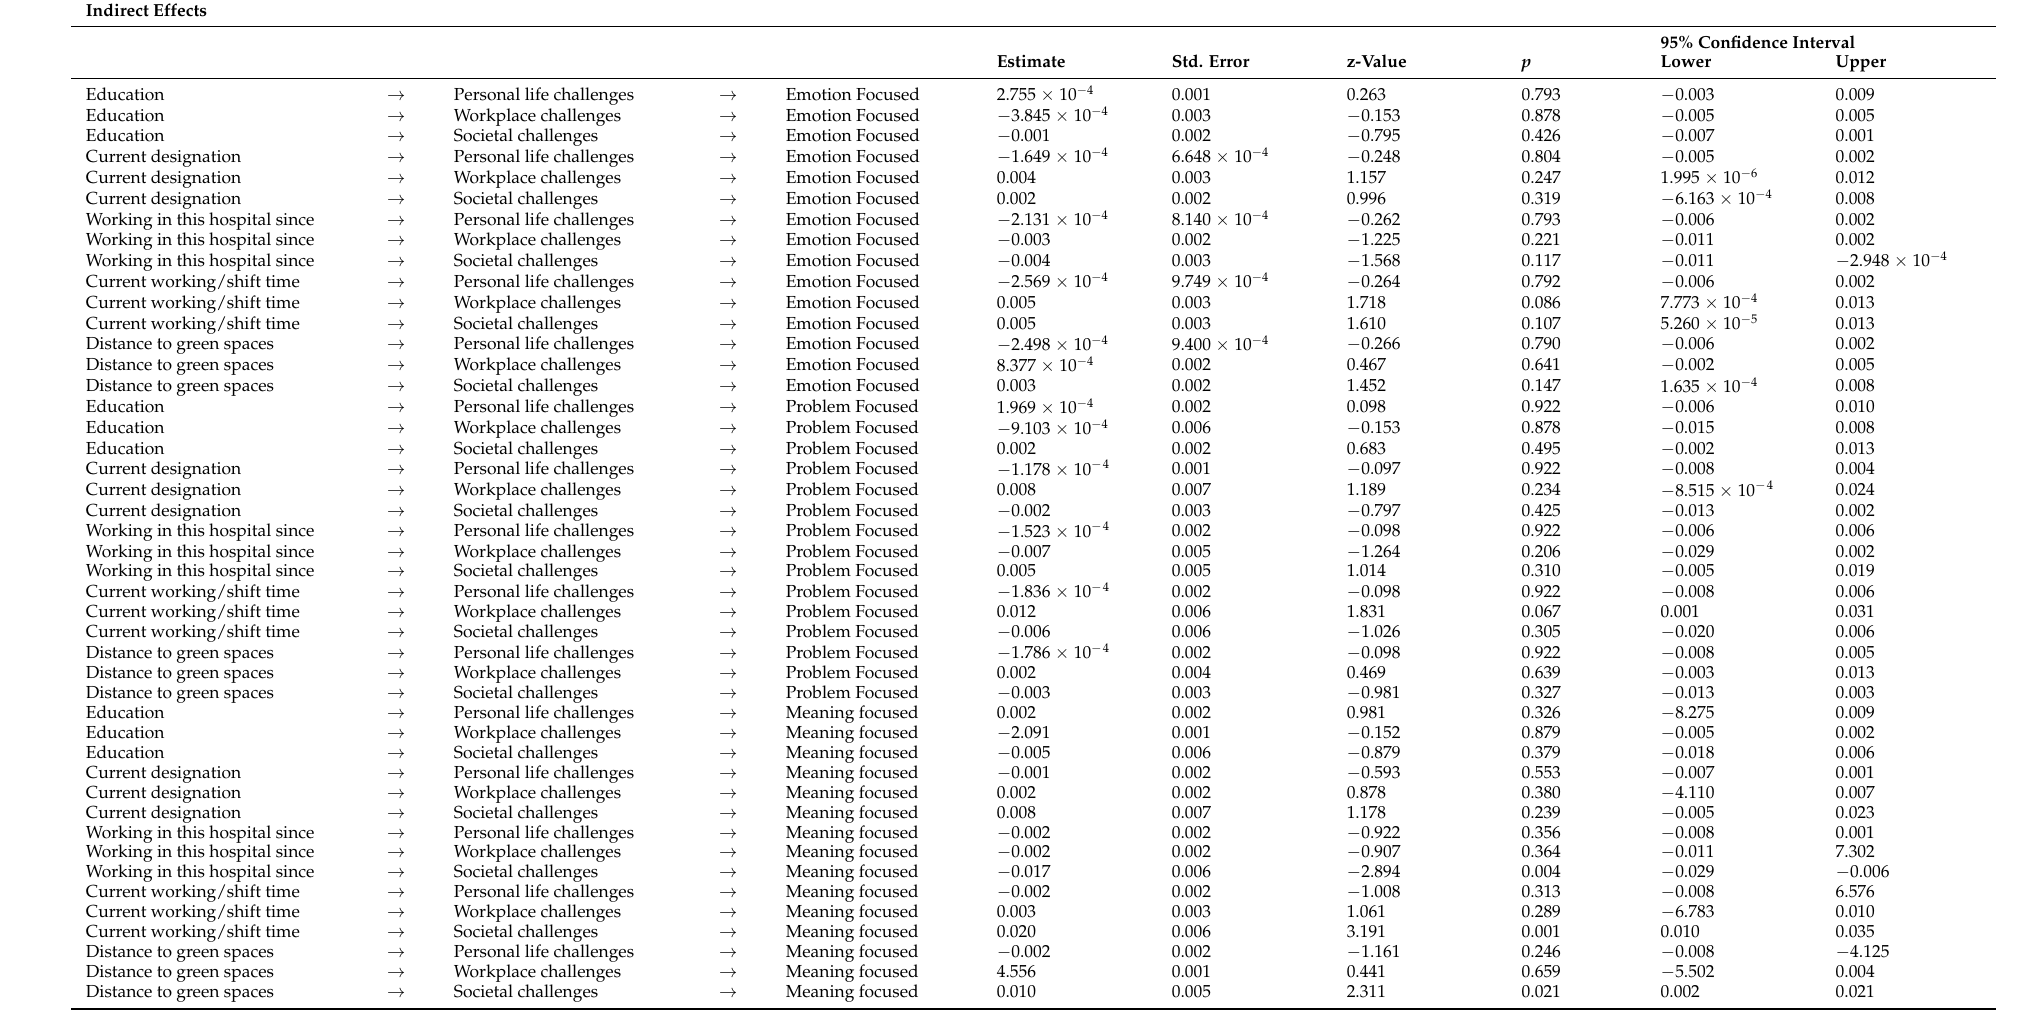
Table 2. Indirect effects of demographics on challenges and coping